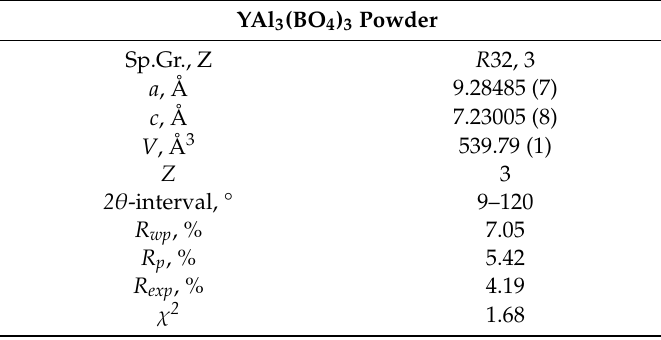
Table 2. Main parameters of processing and refinement of the YAl 3 (BO 4 ) 3